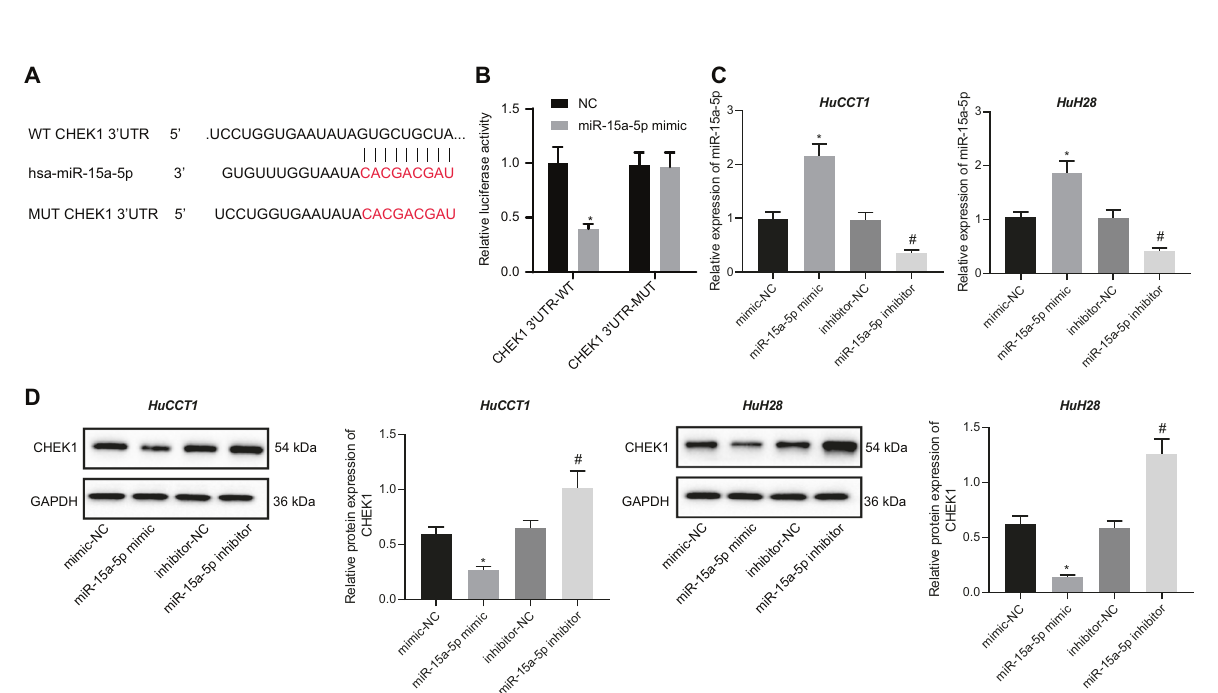
Fig. 1 Bioinformatics analysis predicts the differentially expressed genes and their molecular interactions in CCA. A Interaction network of 50 differentially expressed genes in CCA-microarray GSE26566. Each cycle indicates a gene and the line between two cycles represents the interaction between two genes. More interaction genes of each gene show higher degree value, which display higher core degree with deeper color. B Degree value of the genes with a degree value higher than 15. The abscissa represents degree value and the ordinate represents gene names. C A box plot of CHEK1 expression in the GSE45001 microarray data (10 CCA samples and 10 normal samples). D A box plot of CHEK1 expression in the GSE77984 microarray data (3 CCA samples and 4 normal samples). E Differential expression of CHEK1 in CCA samples in TCGA and GTEx databases. The abscissa represents sample type and the ordinate represents gene expression. The red box indicates tumor sample and gray box indicates normal sample (* P < 0.01). F CHEK1 expression in CCA samples ( n = 145) and normal samples ( n = 35) determined by RT-qPCR. *means comparison against normal samples, P < 0.05. G Prediction of upstream miRNAs regulating CHEK1. The three circles in the fi gure represent the prediction results of the TargetScan, mirDIP, and miRDB databases, and the central part represents the intersection of the three databases. H The binding af fi nity of miR-15a-5p to CHEK1 as well as the binding site of miR-15a-5p in the 3 ’ UTR of CHEK1 mRNA predicted by TargetscanHuman. The data are presented as mean ± standard deviation. Comparison between two groups was conducted using unpaired t -test.